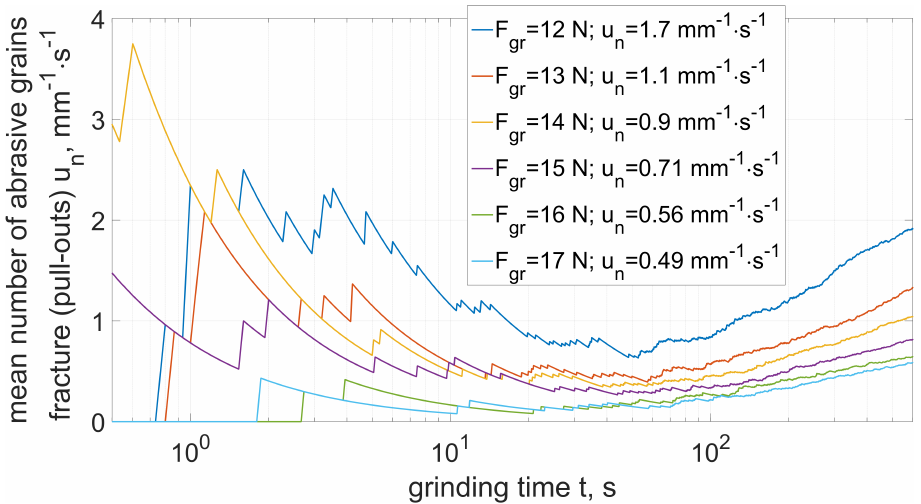
Figure 11. Mean number of abrasive grains fracture (pull-out) depending on grain strength (Equation (30))—case of low intensity (period from t 0 to t 1 ).